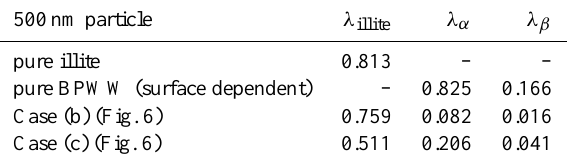
Table 2. Summary of the λ values for 500nm particles of differ- ent composition. They were calculated with the given relations in Sect. 5.1 for BPWW particles and Sect. 5.2 for illite-NX particles. For the calculation of the values of case (b) it was assumed that the soluble volume fraction of the BPWW material in the internally mixed particle is approximately 9.7%. The values for case (c) were estimated by fitting Eq. (7) to the measured data with λ α , λ β and λ illite being the fit parameters, where the relation between λ α and λ β remains the same as derived from the measurements of the pure BPWW. The λ values shown here are only valid for the respective particles generated for the measurements in this study.